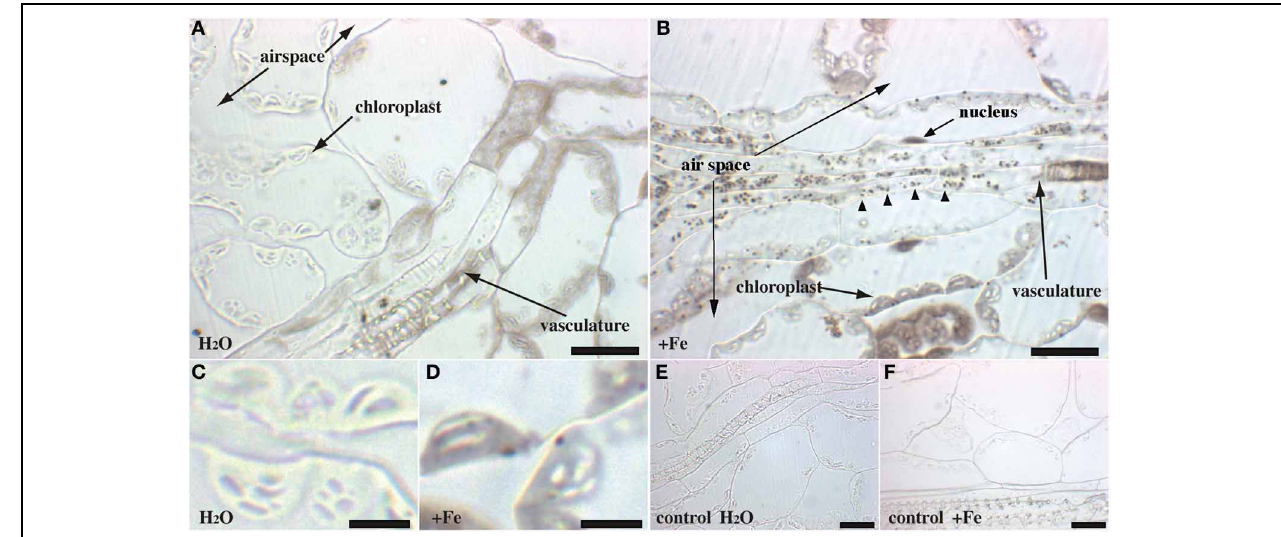
FIGURE 2 | Iron excess in Arabidopsis rosette leaves. Sections of 4-week old WT plants irrigated with either water (A,C,E) or Fe-EDDHA 2mM during 48h (B,D,F) were stained with either Perls/DAB (A–D) or DAB alone as a